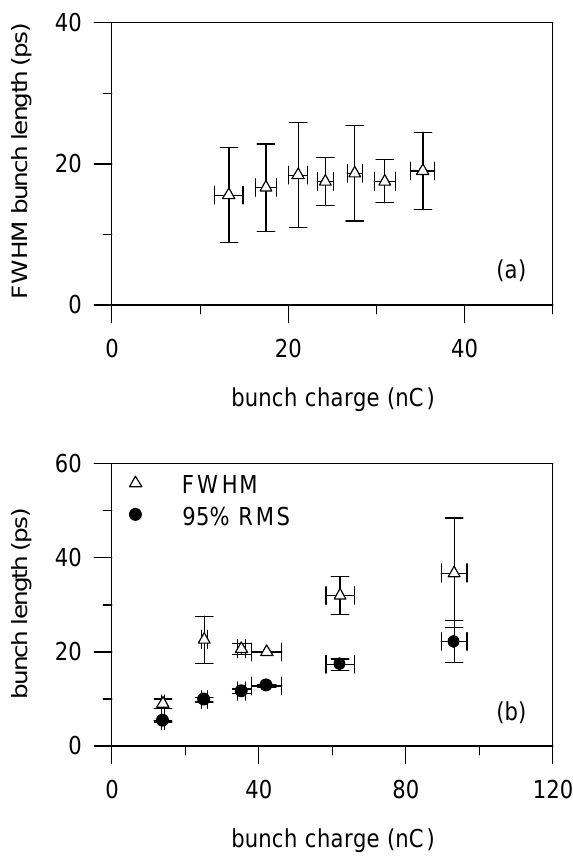
FIG. 3. Measurements of electron bunch length as a function of bunch charge: (a) detailed pulse length measurements in the 15–35 nC range, each point in the plot is the average of 51 pulses; (b) measurement over a wider range of charges, each point represents the average of three pulses. The error bars in each graph represent the standard